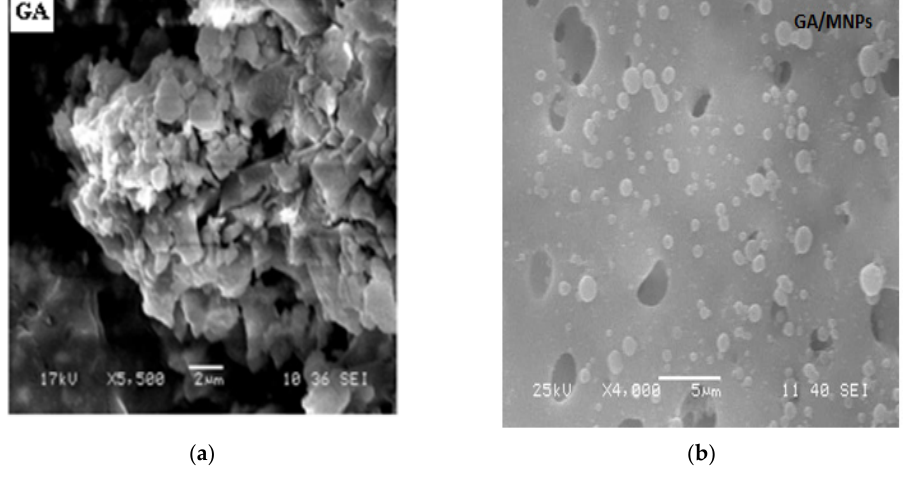
Figure 2. Morphology of ( a ) GA alone and ( b ) GA/MNPs.